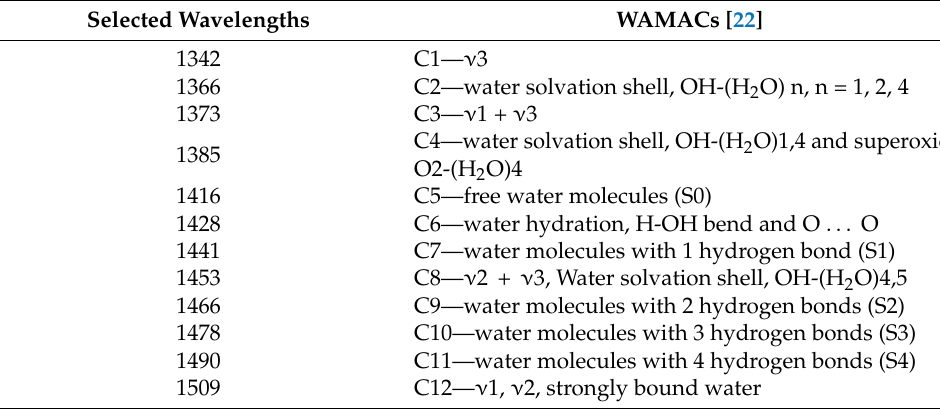
Table 1. Selected